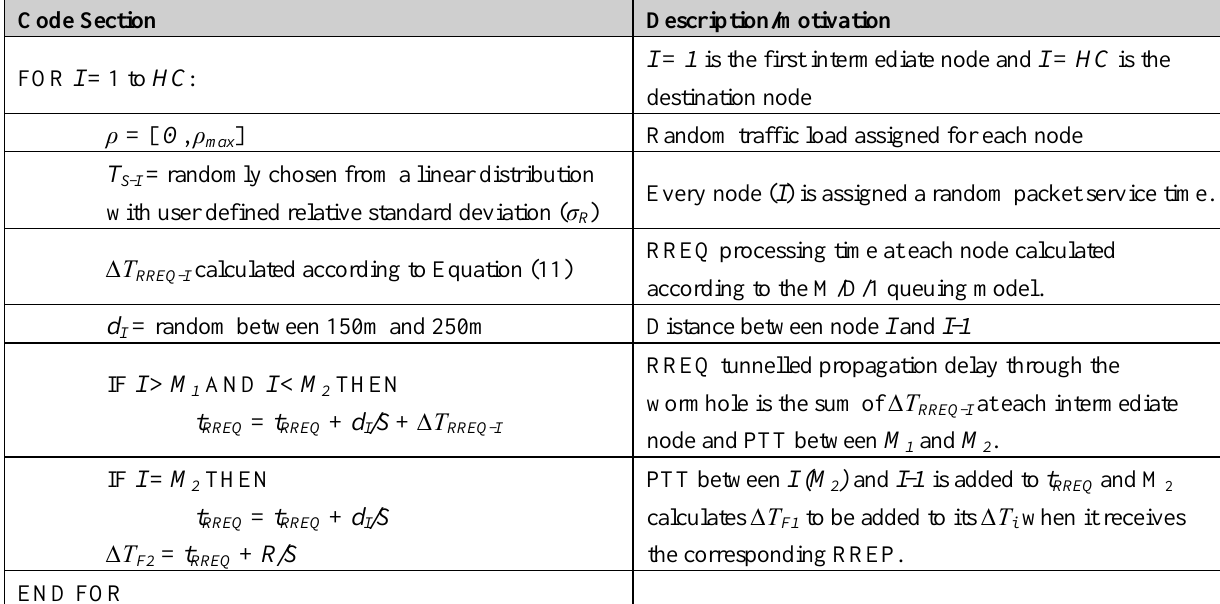
Table A2. Routing packet processing delay generation and malicious node time tampering estimations during the RREQ broadcast